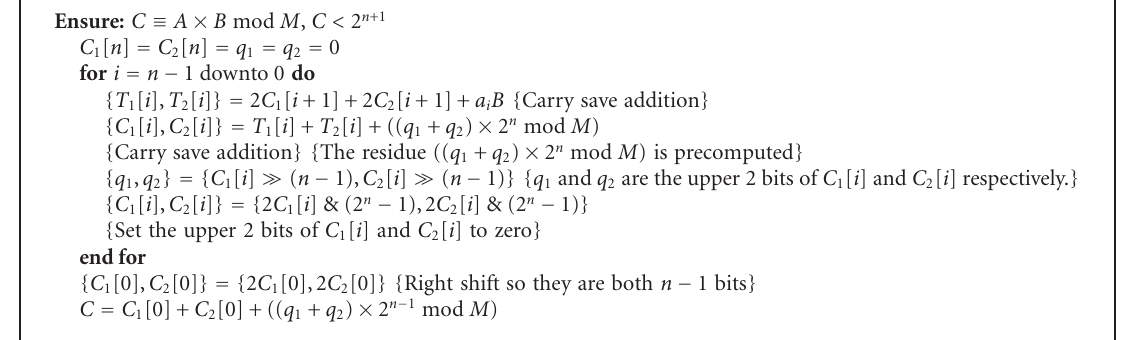
Algorithm 5: New sum of residues modular multiplication.